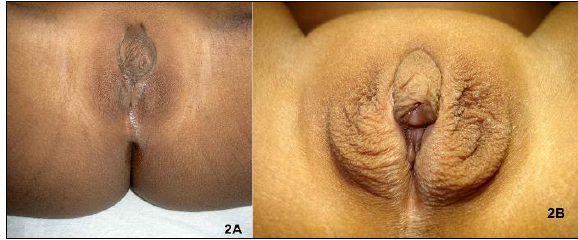
Figure 2: Sex assignment may differ in the same condition according to the degree of cerebral androgen imprinting. Degree of virilization of external genitalia may, but not necessarily, predict the degree of androgen imprinting of brain. (2A) Congenital adrenal hyperplasia (CAH) with minimal virilization (Prader score 2) may predict poor androgen imprinting and hence female assignment is appropriate. (2B). CAH with severe virilization (Prader score 4) are often dissatisfied with female sex assignment. It is probably due to strong androgen imprinting and hence male assignment is appropriate in this